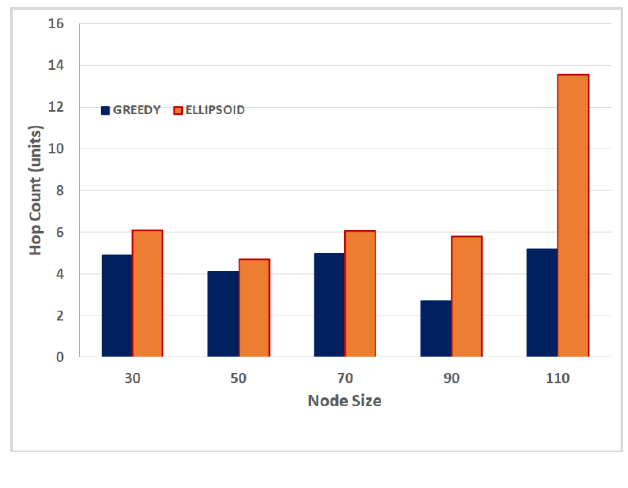
Figure 5. Average hop count (VANET case)